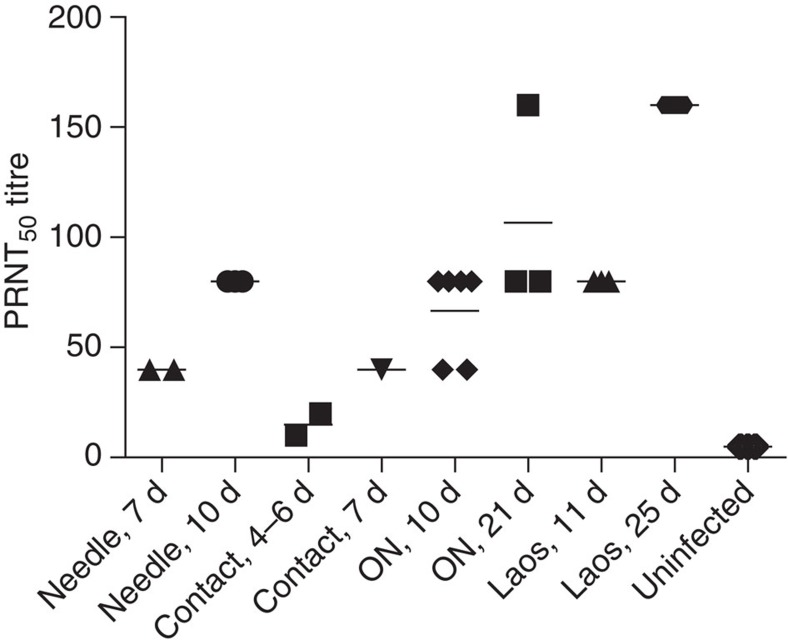
Virus neutralization titres.Sera obtained from experimentally infected groups were obtained at the indicated days (d) p.i. and tested in a PRNT test. Needle: animals infected with the Nakayama strain (Fig. 1); contact: animals infected by contact (see Fig. 1, time point p.i. is estimated); ON: pigs infected via the oronasal route (Fig. 4); Laos: pigs infected i.d. with the Laos strain of JEV (106 TCID50).